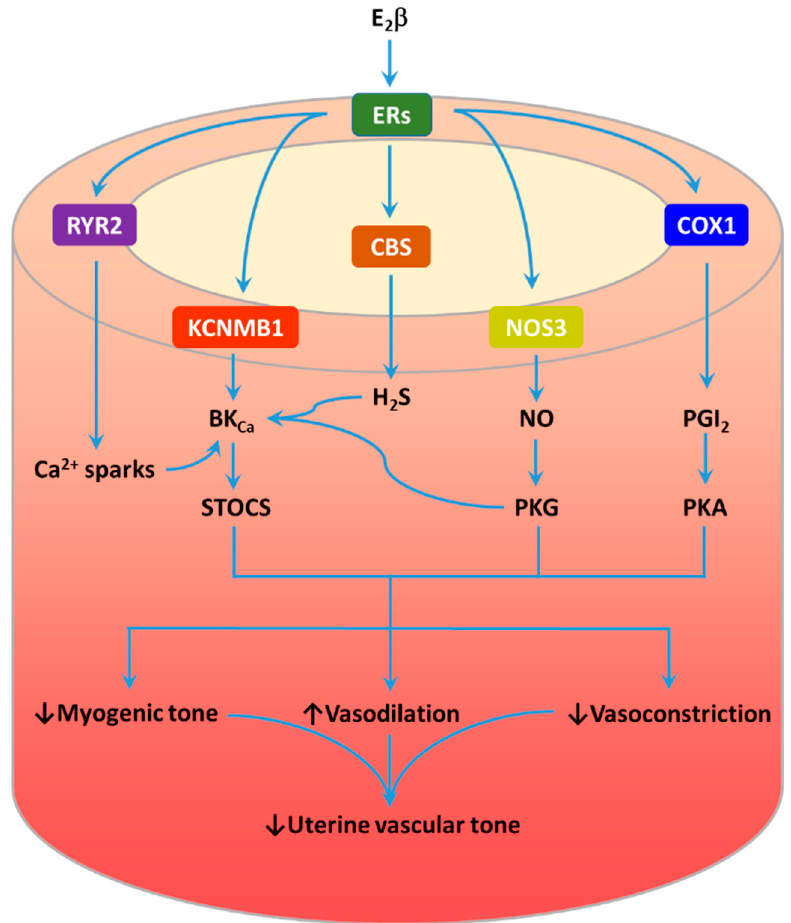
Figure 2. Estrogen plays a pivotal role in regulating functional adaptation of uteroplacental vessels in pregnancy. 17 β -Estradiol (E 2 β ) upregulates RYR2 and KCNMB1 expression and ryanodine receptor 2 (RyR 2 ) and large-conductance Ca 2+ -activated K + (BK Ca ) channel activity and subsequently enhances Ca 2+ spark/STOC coupling, leading to reduced uterine arterial myogenic tone. E 2 β also increases production/release of nitric oxide (NO), hydrogen sulfide (H 2 S) and prostacyclin (PGI 2 ) via upregulating the expression of NOS3, CBS and COX1 in uterine arteries. These vasodilators, through receptor or nonreceptor mechanisms to activate protein kinase A (PKA) and protein kinase G (PKG), promote vasodilation and blunt vasoconstriction, resulting in an overall decrease in uterine vascular tone.